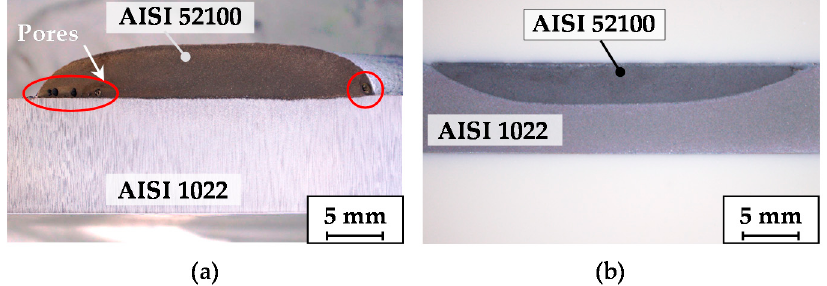
Figure 5. ( a ) Section view of the cladded workpiece welded with a single seam and ( b ) of a near-net-shaped bearing washers after forging (etched with nitric acid solution).